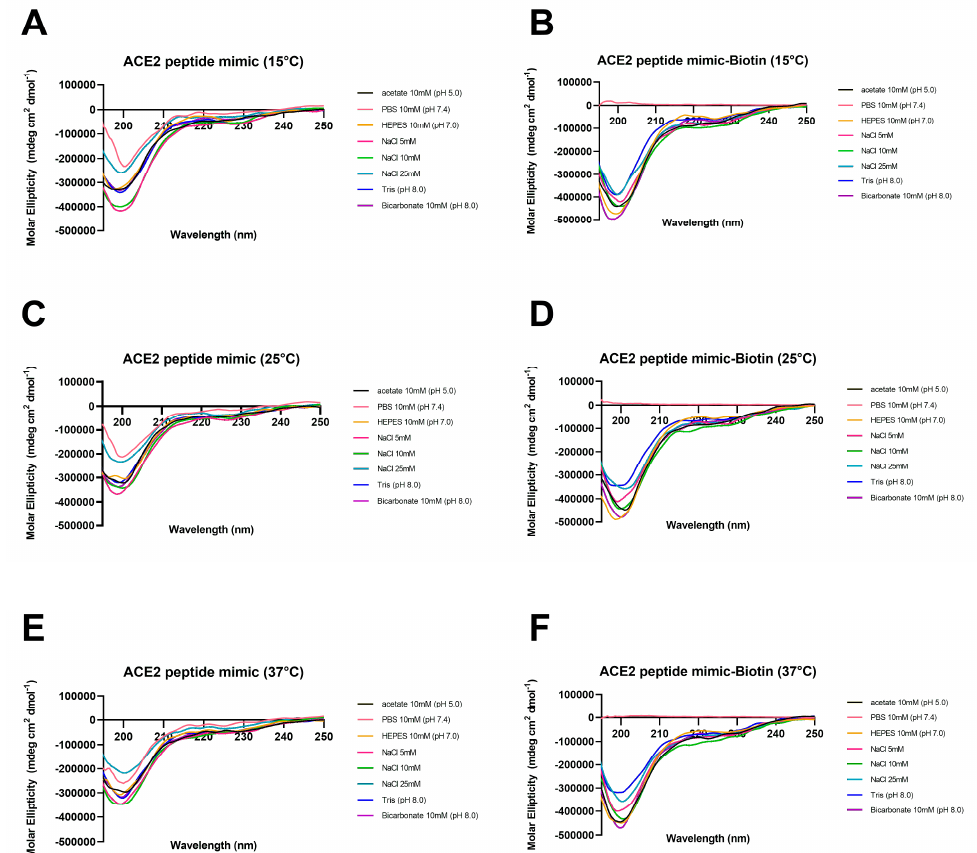
Figure 2. Effect of different environmental conditions on ACE2 peptide mimic stability. Circular dichroism spectra of synthetic biotinylated ACE2 peptide mimic and the non-biotinylated one were obtained at different temperatures—( A , B ) 15 °C, ( C , D ) 25 °C, and ( E , F ) 37 °C—and different buffer solutions at 10 mM of acetate (pH 5.0), PBS (pH 7.0), HEPES (pH 7.0), Tris-HCl (pH 8.0), and bicarbonate (pH 8.0). Osmolarity influence was tested using different NaCl concentrations (5, 10, and 25 mM) in the Milli-Q water.